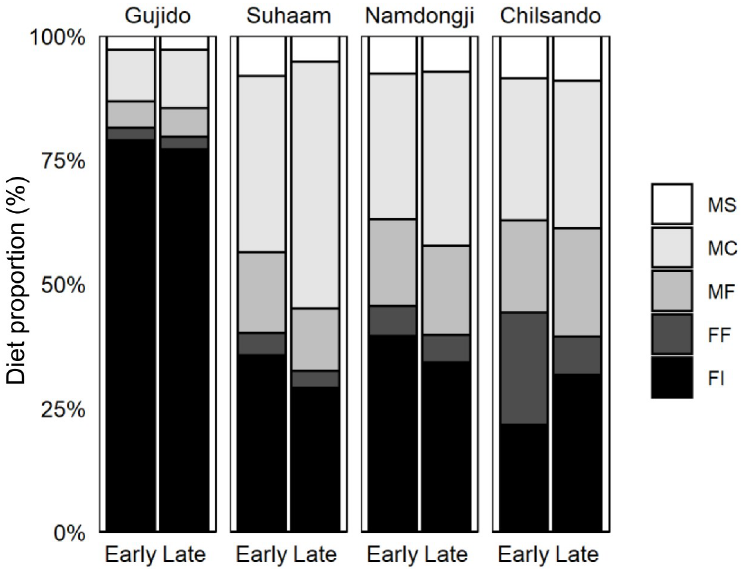
Fig 5. Estimated proportion of freshwater and marine prey in the diet of Black-faced Spoonbills at four breeding colonies during two chick-rearing periods. FF: freshwater fish, FI: freshwater invertebrate, MF: marine fish, MS: marine shrimp, and MC: marine